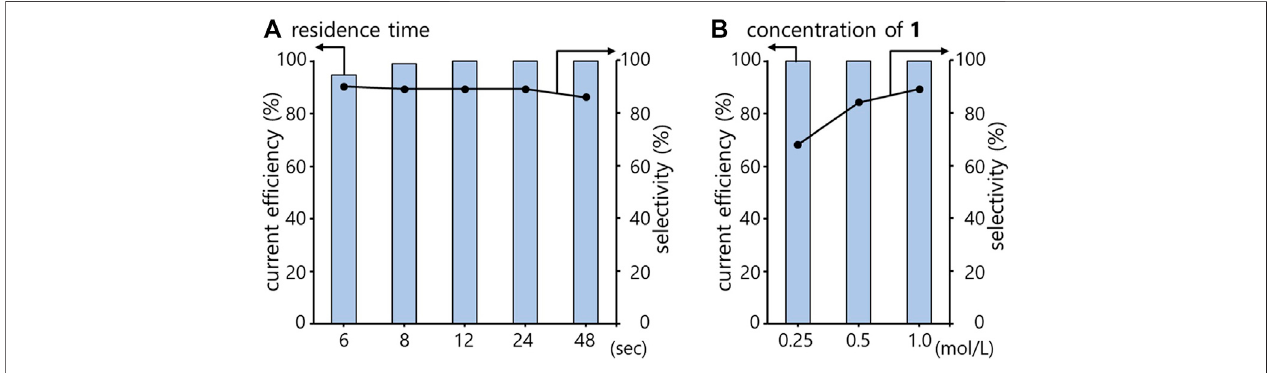
FIGURE 1 | Semihydrogenation of 1 in a PEM reactor varying the residence time (A) and the concentration of 1 (B) . Bar, current ef fi ciency; dot, selectivity for 2 . Conditions: solvent, methylcyclohexane; electrocatalyst, Pd; temperature, rt; current density, 7.5 mA/cm 2 ; Concentration of 1 in (A) , 1.0 M; residence time in (B) , 24 s.